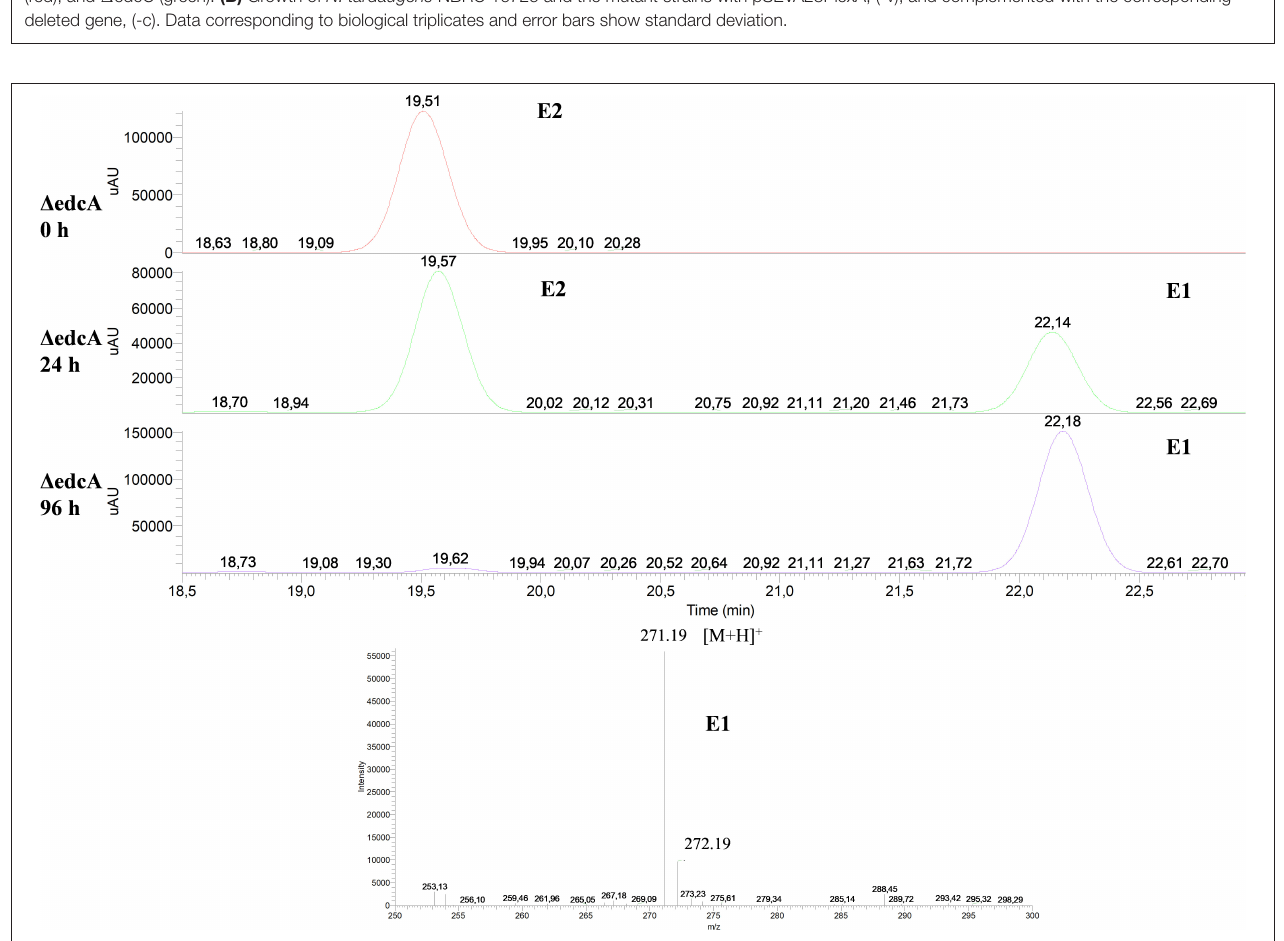
FIGURE 6 | HPLC-MS analysis of the organic phase extracted from cultures of N. tardaugens 1 edcA in NB rich medium supplemented with 2mM E2. UV chromatograms at 282nm of the samples at 0, 24, and 96h and mass spectrum of the peak detected at 22.18min (E1).